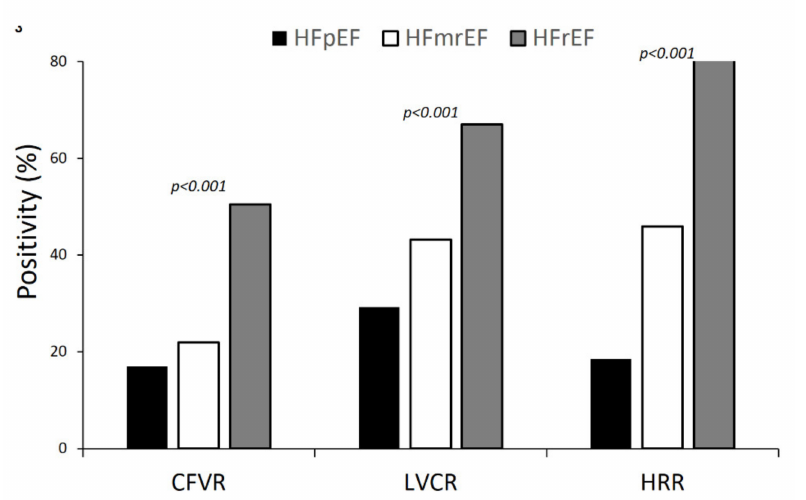
Figure 3. Dipyridamole stress echocardiography (DSE) results: positivity rate for each of the 3 pa- rameters (LVCR, CFVR, and HRR) in the 3 groups (i.e., HFpEF, HFmrEF, and HFrEF). All intergroup differences are significant.